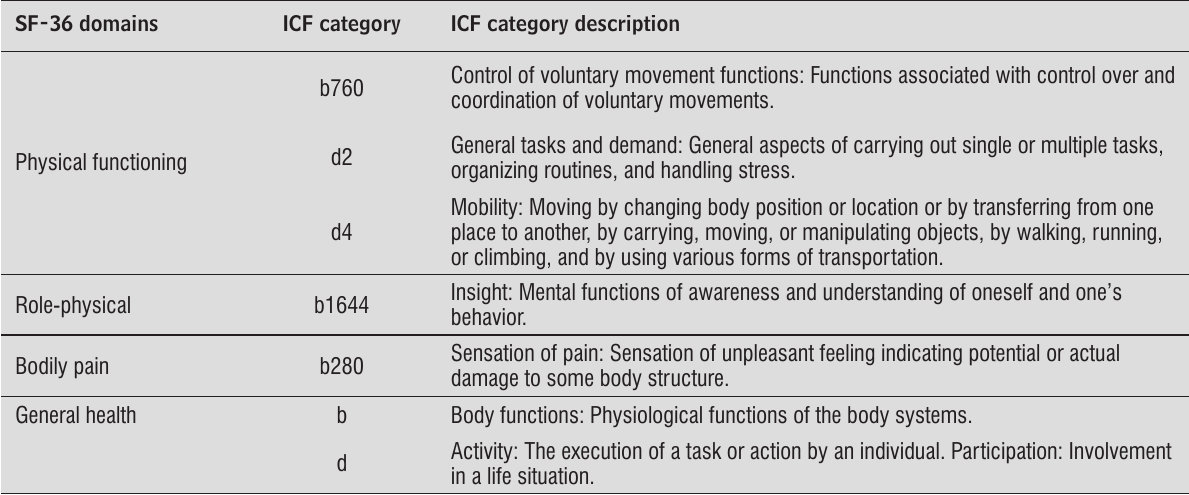
Table 2 - Proposed relationship between SF-36 domains and ICF